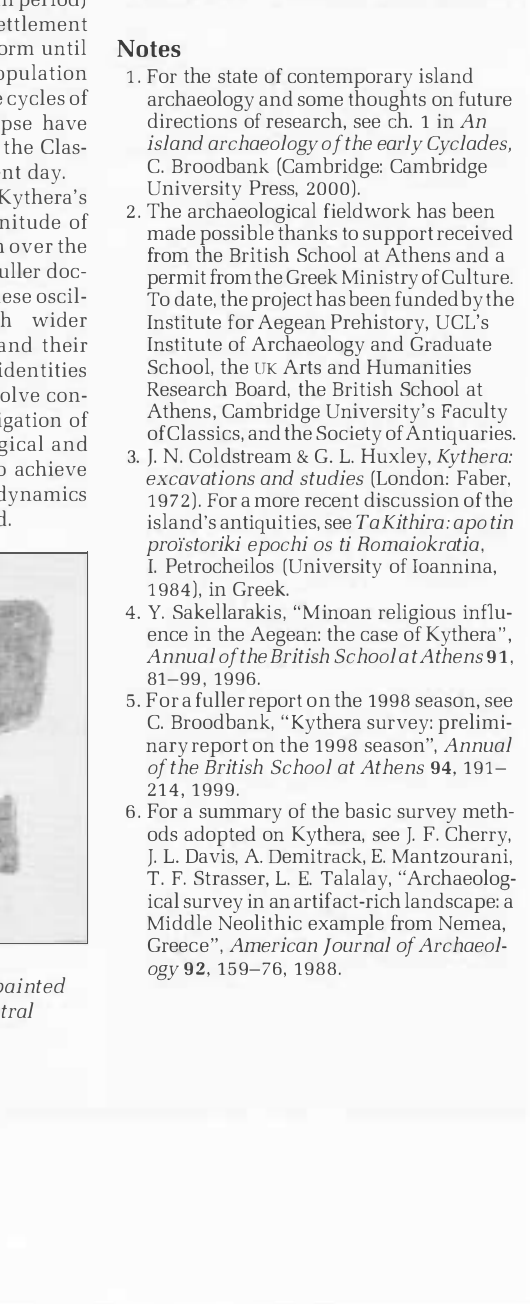
Figure 5 Aerial view of the site of Kastri, taken from a kite; the defensive walls of the early Byzantine shore fort are clearly